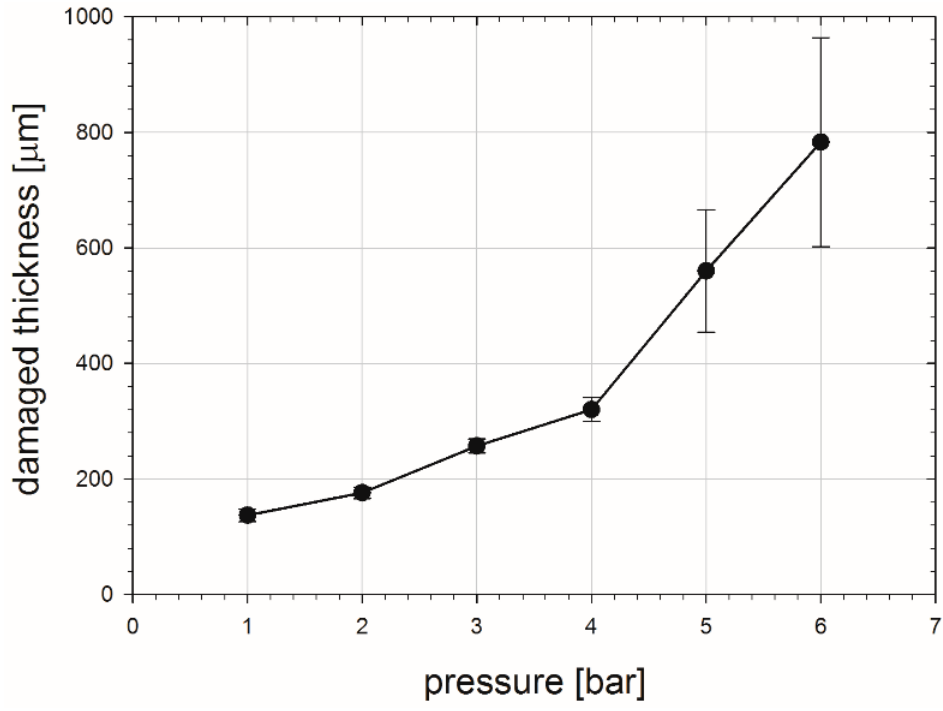
Figure 8. Total thickness of the damaged zones obtained from PAS measurements dependent on the pressure applied in the sandblasting of copper.